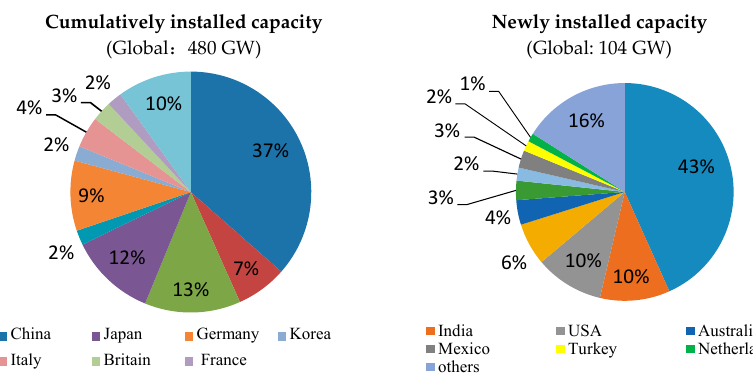
Figure 1. Global ranking of installed PV capacity in 2018.